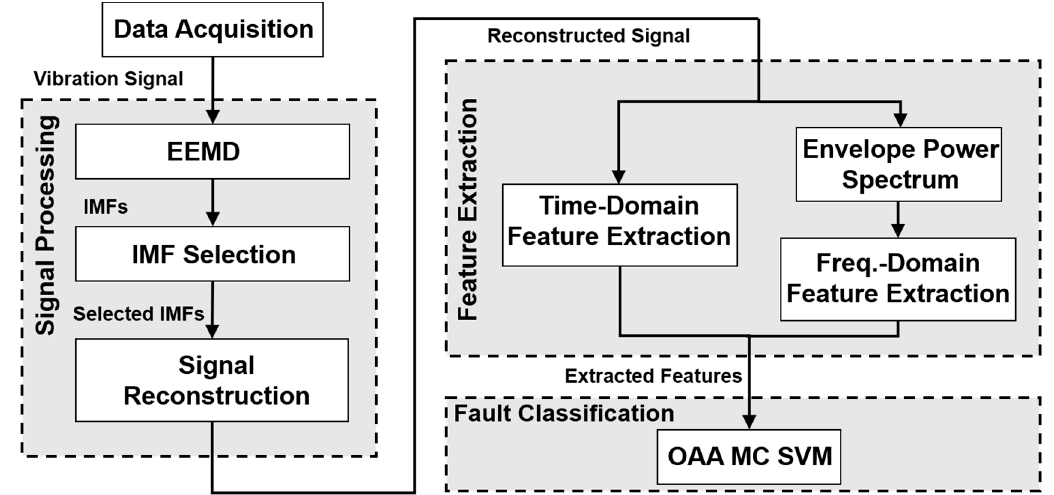
Figure 1. A block diagram of the proposed fault diagnosis framework including informative IMF selection, fault feature extraction, and one-against-all multi-class support vector machine (OAA MC SVM)-based fault classification. EEMD, ensemble empirical mode decomposition; IMF, intrinsic mode function.